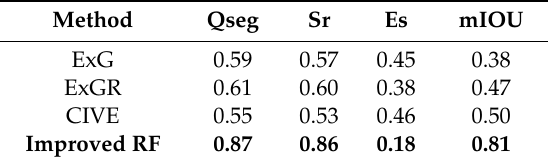
Table 6. Comparison of segmentation quality for ExG, ExGR, CIVE and the proposed method (improved